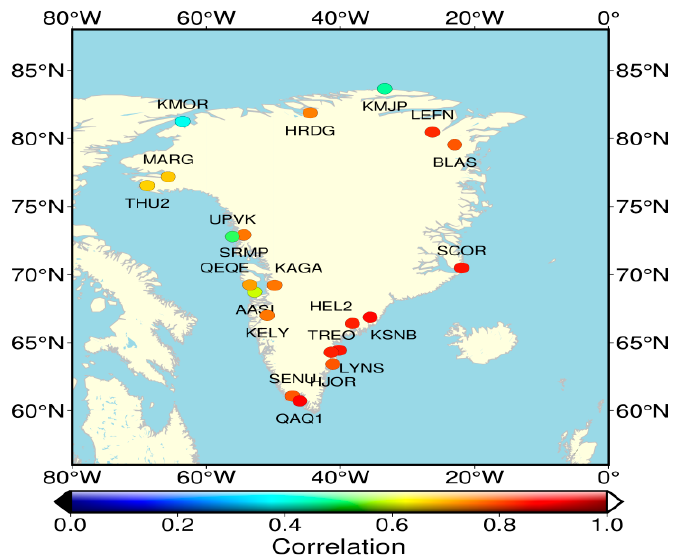
Figure 11. Correlation between GPS and GRACE data in seasonal vertical deformation.